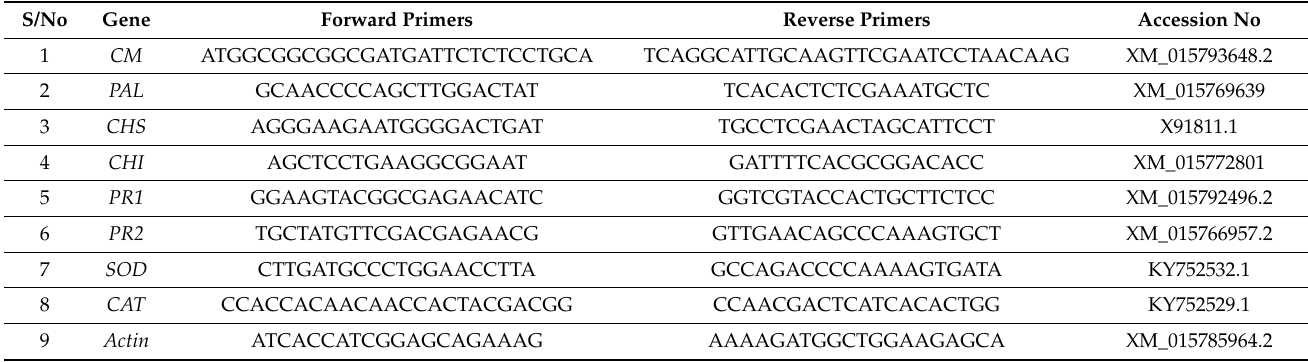
Table 1. Primers designed by NCBI for qRT-PCR and accession number of selected